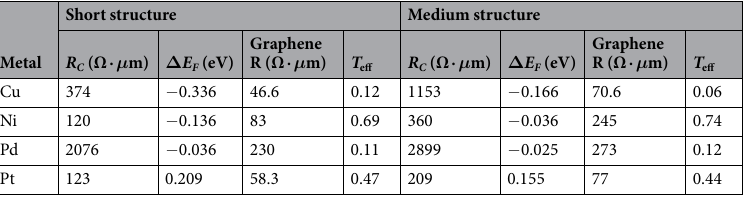
Table 3. Analysis of the simulation results for the contact resistance. Ballistic resistance of graphene in the semi-infinite lead applied to the symmetry point (point A or B for medium and short structures, respectively) of the structure (Graphene R) and resistance of the graphene-metal contacts ( R c ) for different metals and length of the simulated structure. T eff is the ratio of Graphene R to Total R and depends on the metal species but not on the length of the